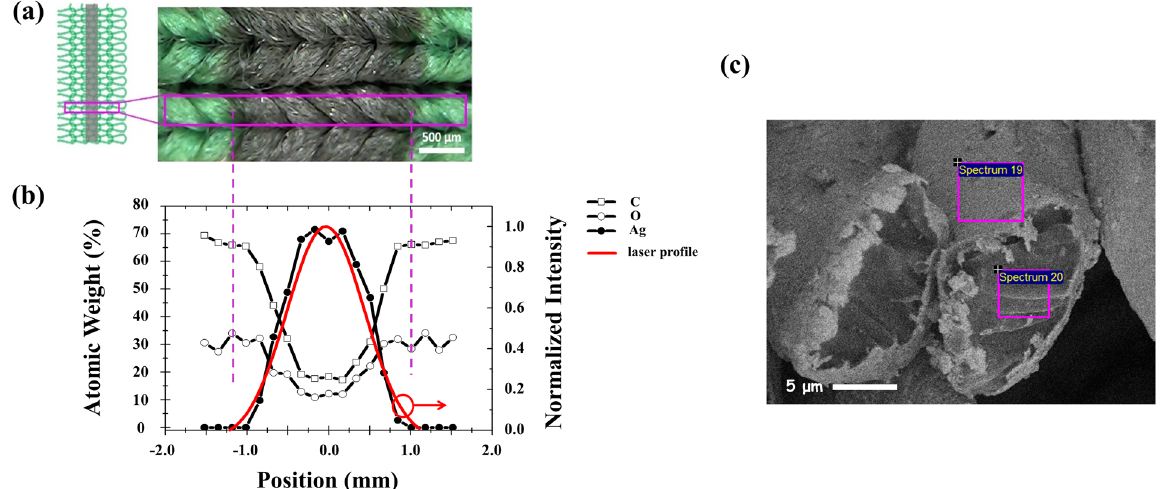
Figure 1. ( a ) Optical image of a typically metallized weft-knitted fabric where the dark region is Ag rich with high definition edges. ( b ) Relative atomic weight of elements C, O, and Ag measured by EDS. Also shown is the normalized laser intensity which correlates closely with the distribution of Ag element. ( c ) SEM image of the cross-section of the as-metallized